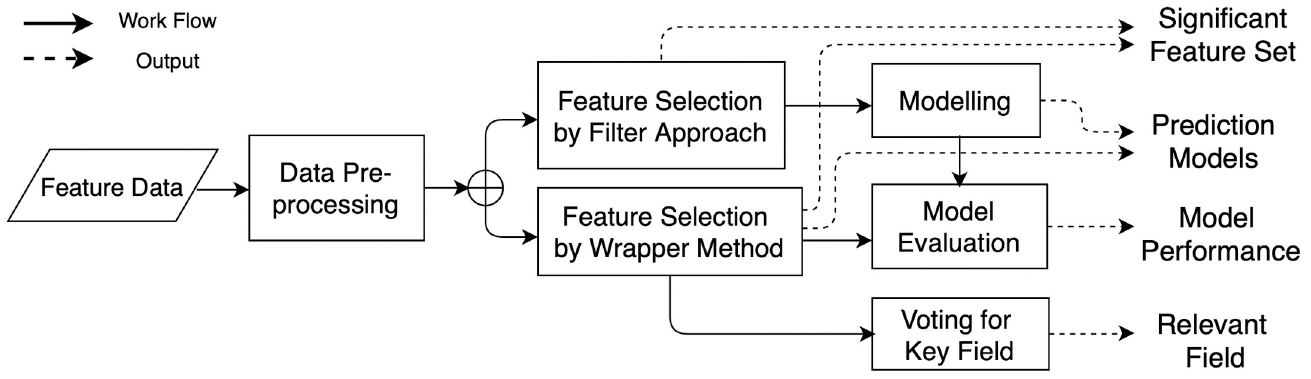
Fig 1. Workflow design.